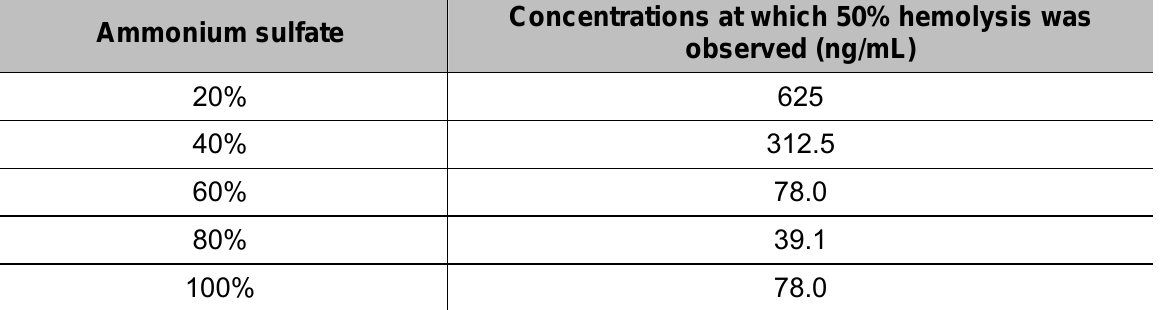
Table 1. Hemolytic activity of different ammonium sulfate fractions Ammonium sulfate